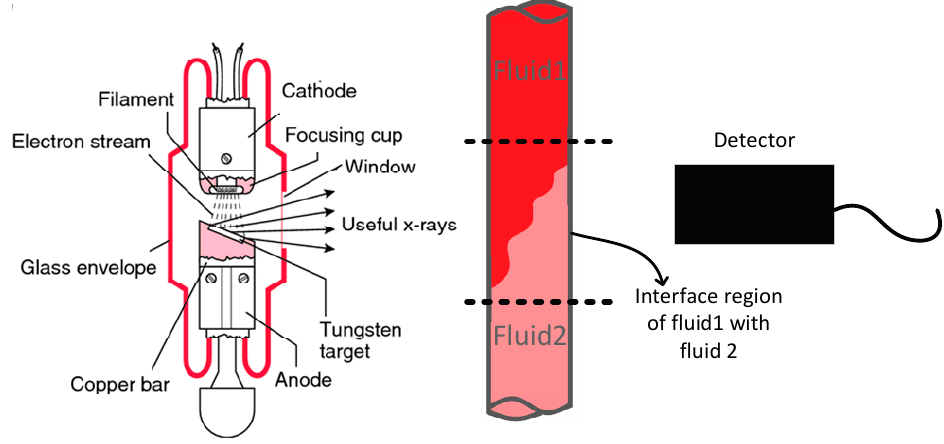
Figure 1. The simulation setup.